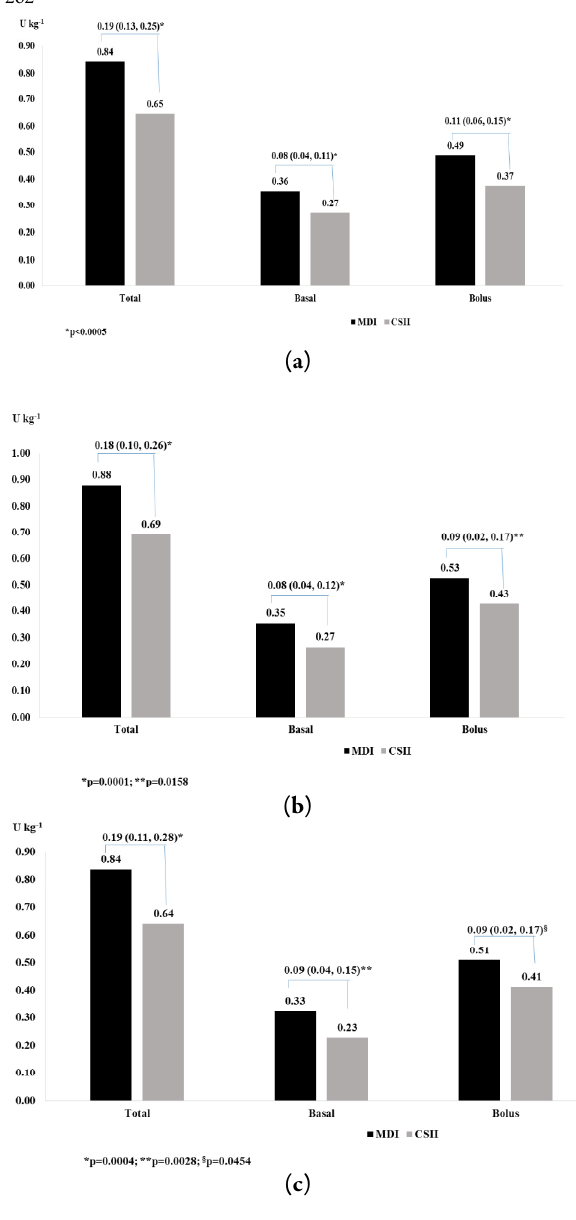
Fig. 1(a) MDI to CSII insulin dose change in patients with high HbA1c ≥ 8.5% pump indication; (b) MDI to CSII insulin dose change in patients with inappropriate/ impractical MDI insulin pump indication; (c) MDI to CSII insulin dose change in patients with recurrent hypoglycaemia insulin pump indication; p values according to paired